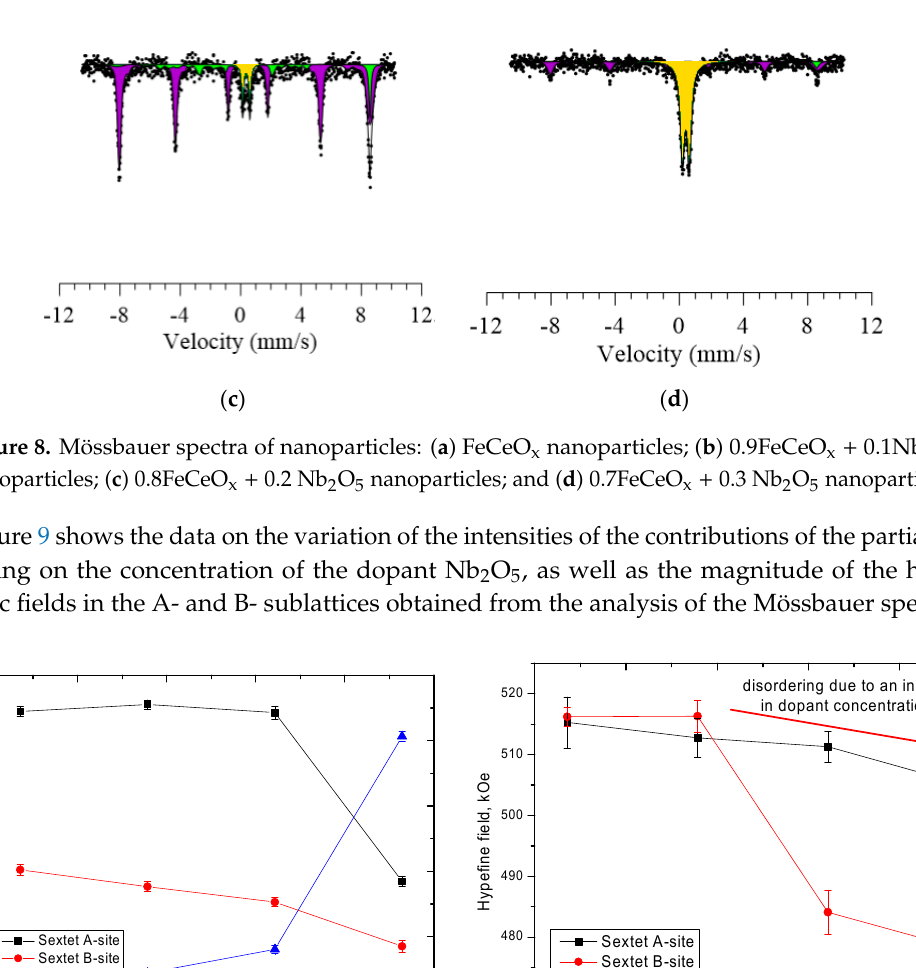
Figure 9. Changes in the hyperfine parameters of magnetic characteristics obtained on the basis of the analysis of Mössbauer data: ( a ) data of changes of contribution intensities of partial spectra depending on concentration of dopant Nb 2 O 5 ; ( b ) data on changes in the magnitude of hyperfine magnetic fields in the A- and B- sublattices.